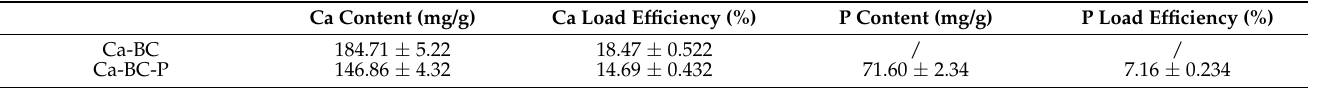
Table 3. Basic parameters of Ca-BC before and after